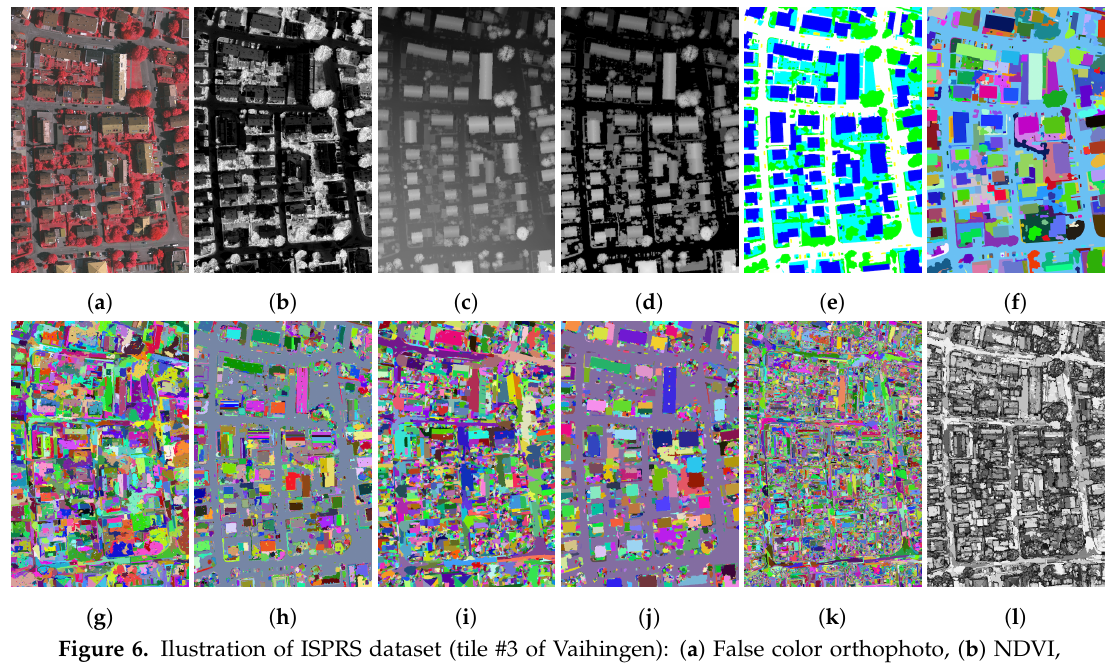
Figure 6. Ilustration of ISPRS dataset (tile #3 of Vaihingen): ( a ) False color orthophoto, ( b ) NDVI, ( c ) DSM, ( d ) nDSM, ( e ) reference map, ( f ) reference segmentation, ( g , h ) Felzenszwalb IRRG and nDSM, ( i , j ) Mean-shift IRRG and nDSM, ( k ) super-pixels, ( l ) confidence map. All segmentation and super-pixels maps are given in random